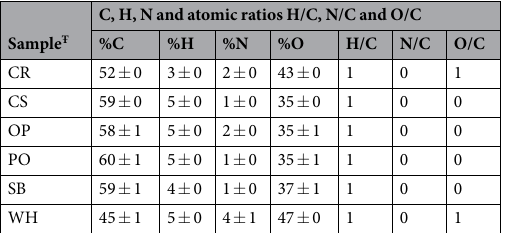
Table 2. Elemental analysis (C, H, N, O, and atomic ratios H/C, N/C, and O/C) of the biochar samples. Ŧ CR = charcoal fines; CS = coconut shell; OP = orange peel; PO = palm oil bunch; SB = sugarcane bagasse; WH = water